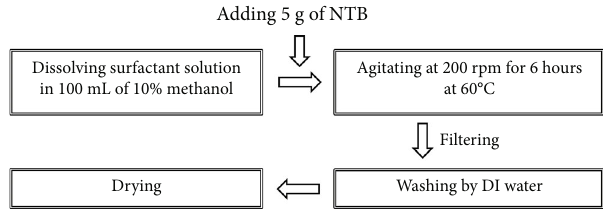
Figure 1: The schematic steps of the MTB modi fi